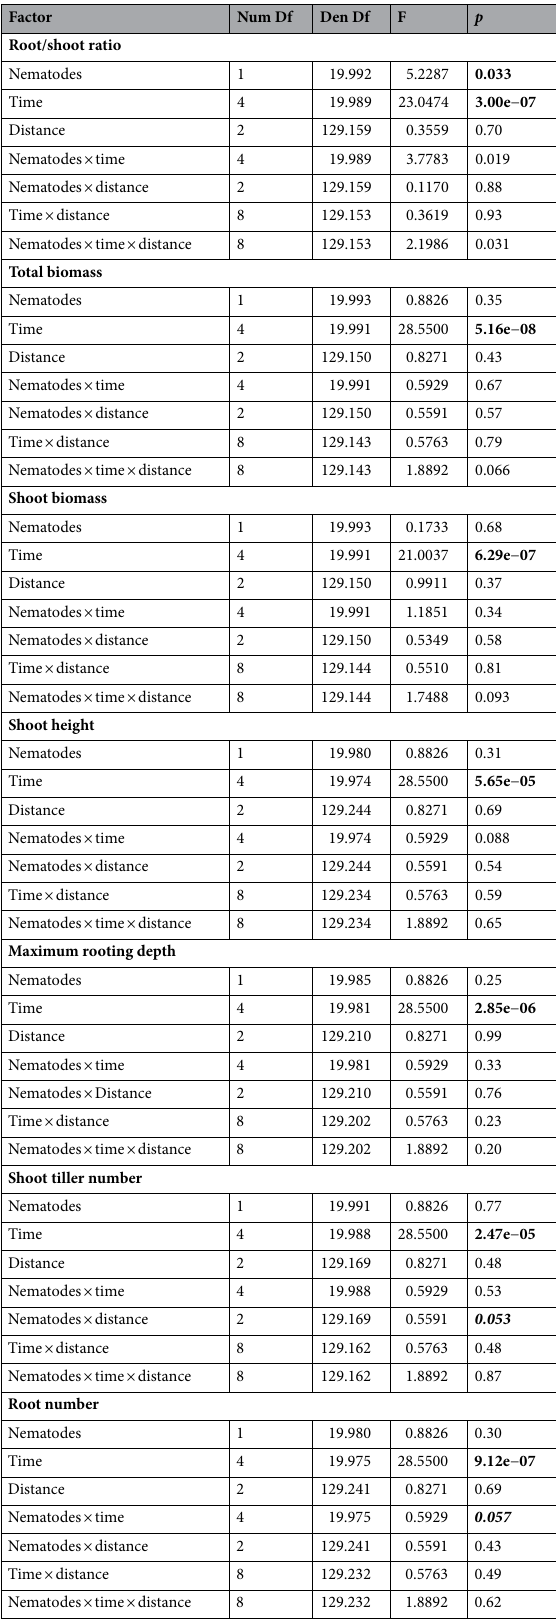
Table 2. Effect of nematode inoculation, distance from the focal plant, and sample harvest time for leachate collection on measured traits of receiver plants. P < 0.05 is highlighted in bold. P ≥ 0.05 is highlighted in